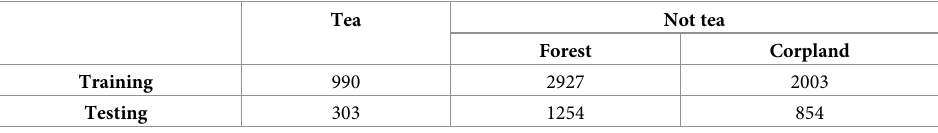
Table 5. Training and validation